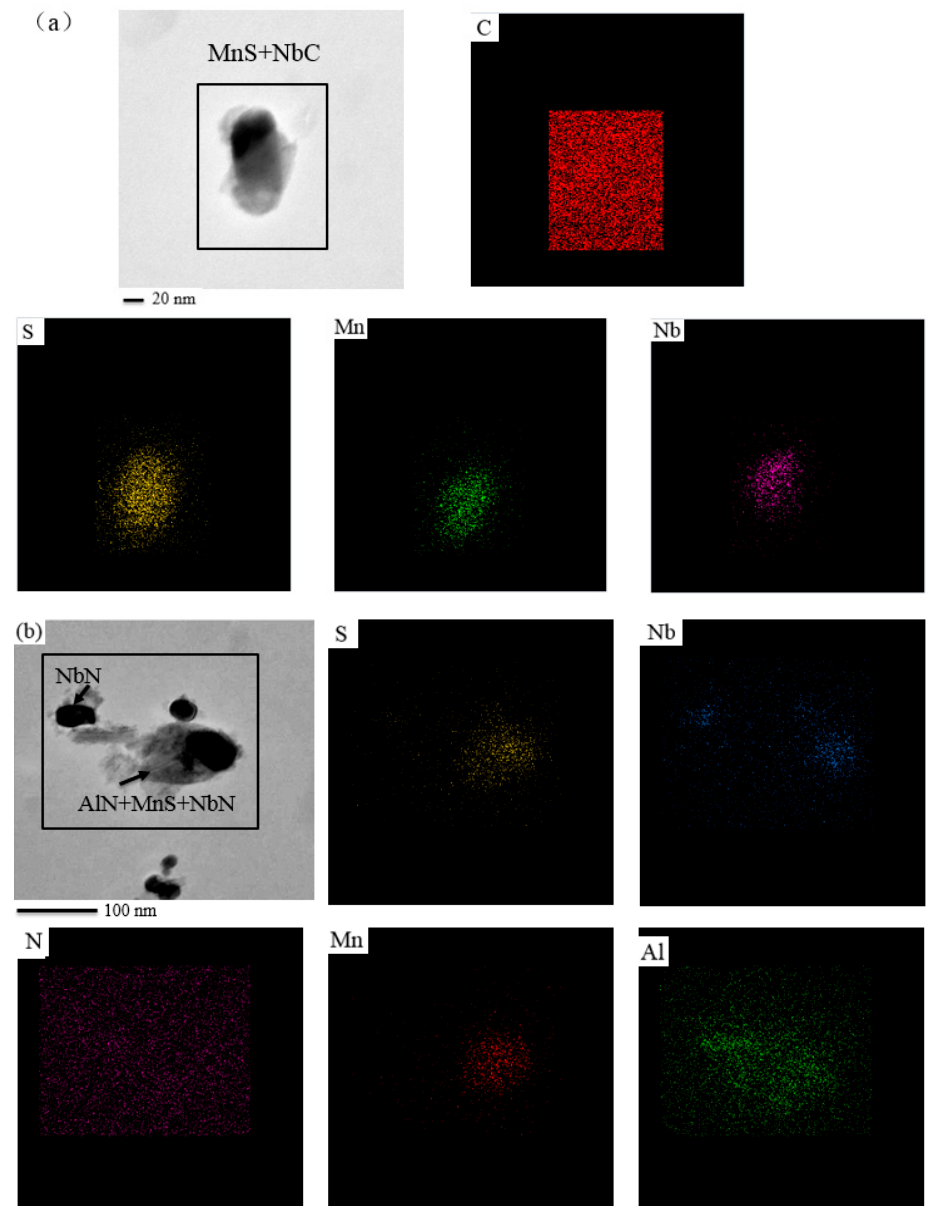
Figure 2. Element mapping results of the precipitates.